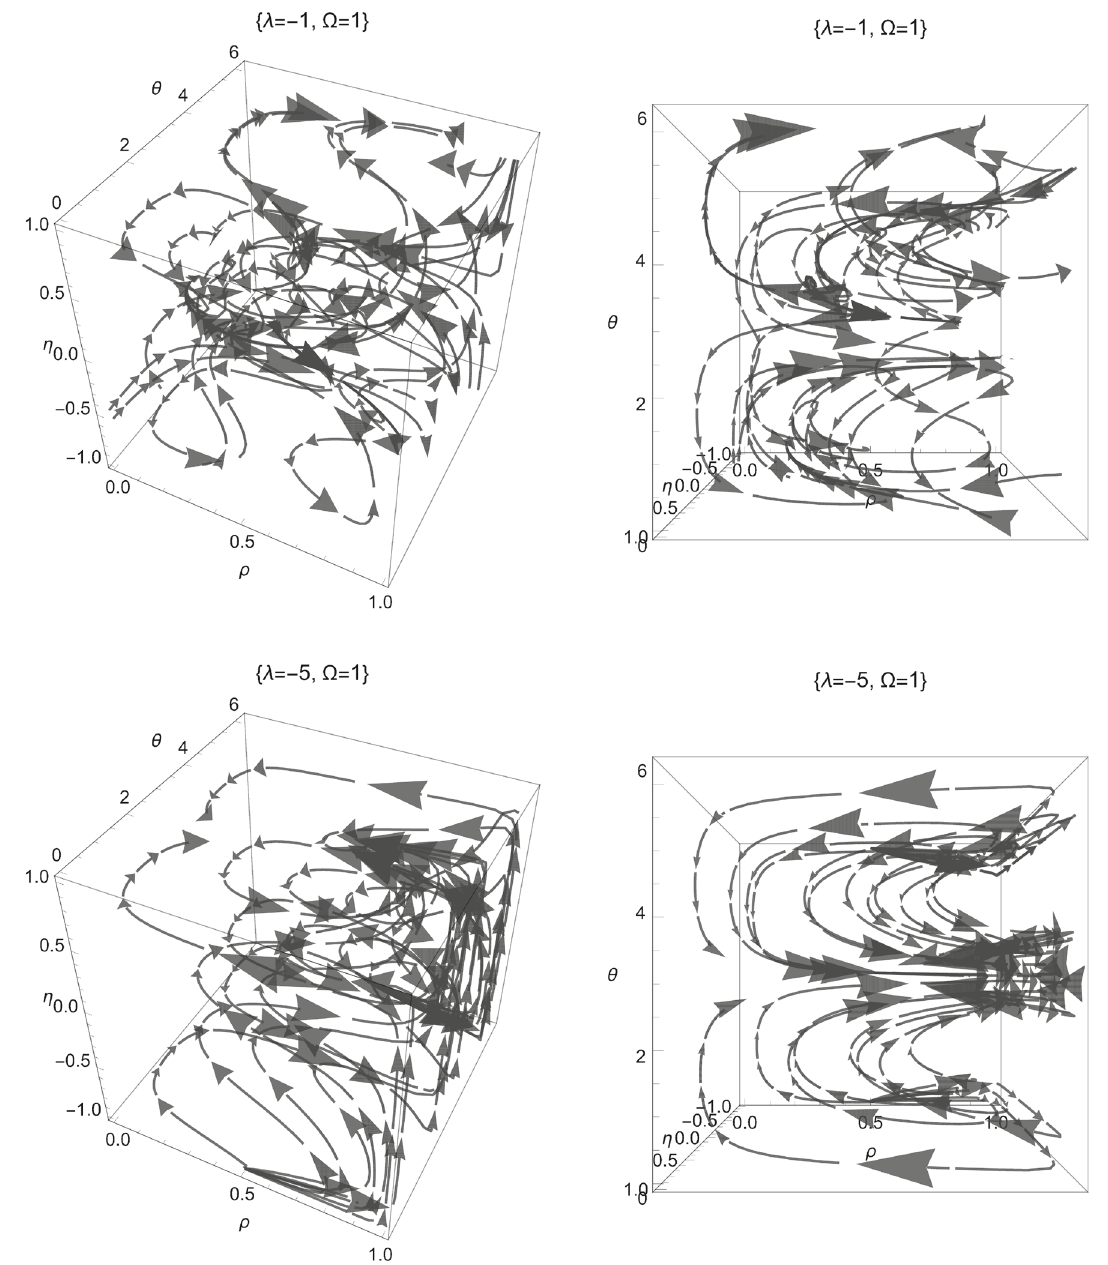
Fig. 5 Phase-space portraits for the three-dimensional dynamical sys- tem in the space (ρ,θ,η) for the Kantowski–Sachs spacetime and for ω = − 1 , that is (cid:18) = 1. First row are plots with λ = − 1 while in the second row are plots with λ = − 5 . The plots of the left and right